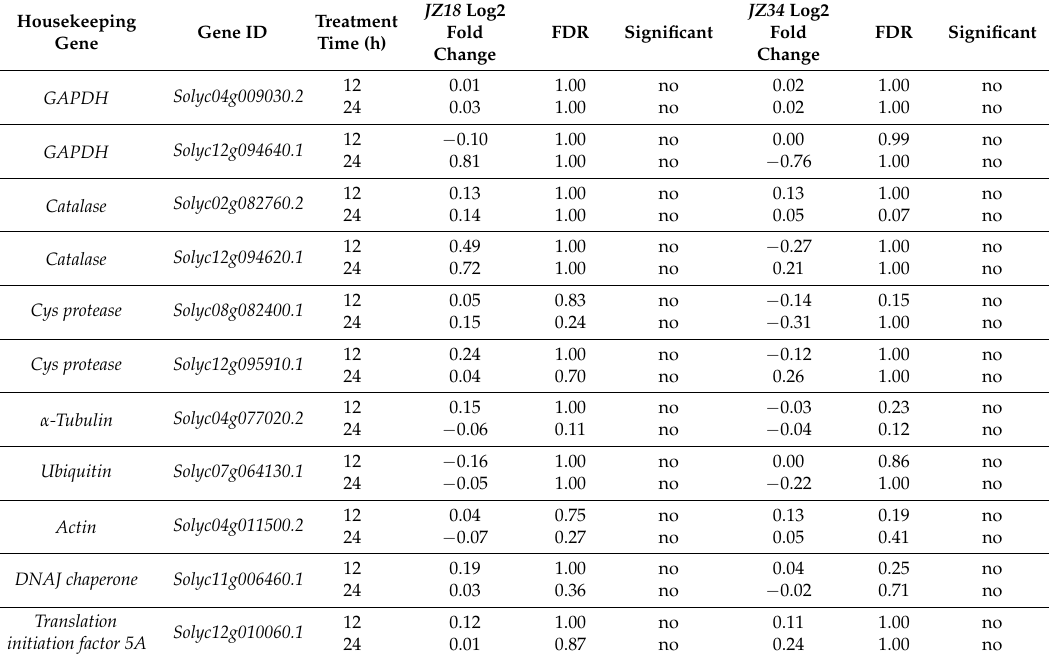
Table 3. Expression levels of the housekeeping control genes at 12 h and 24